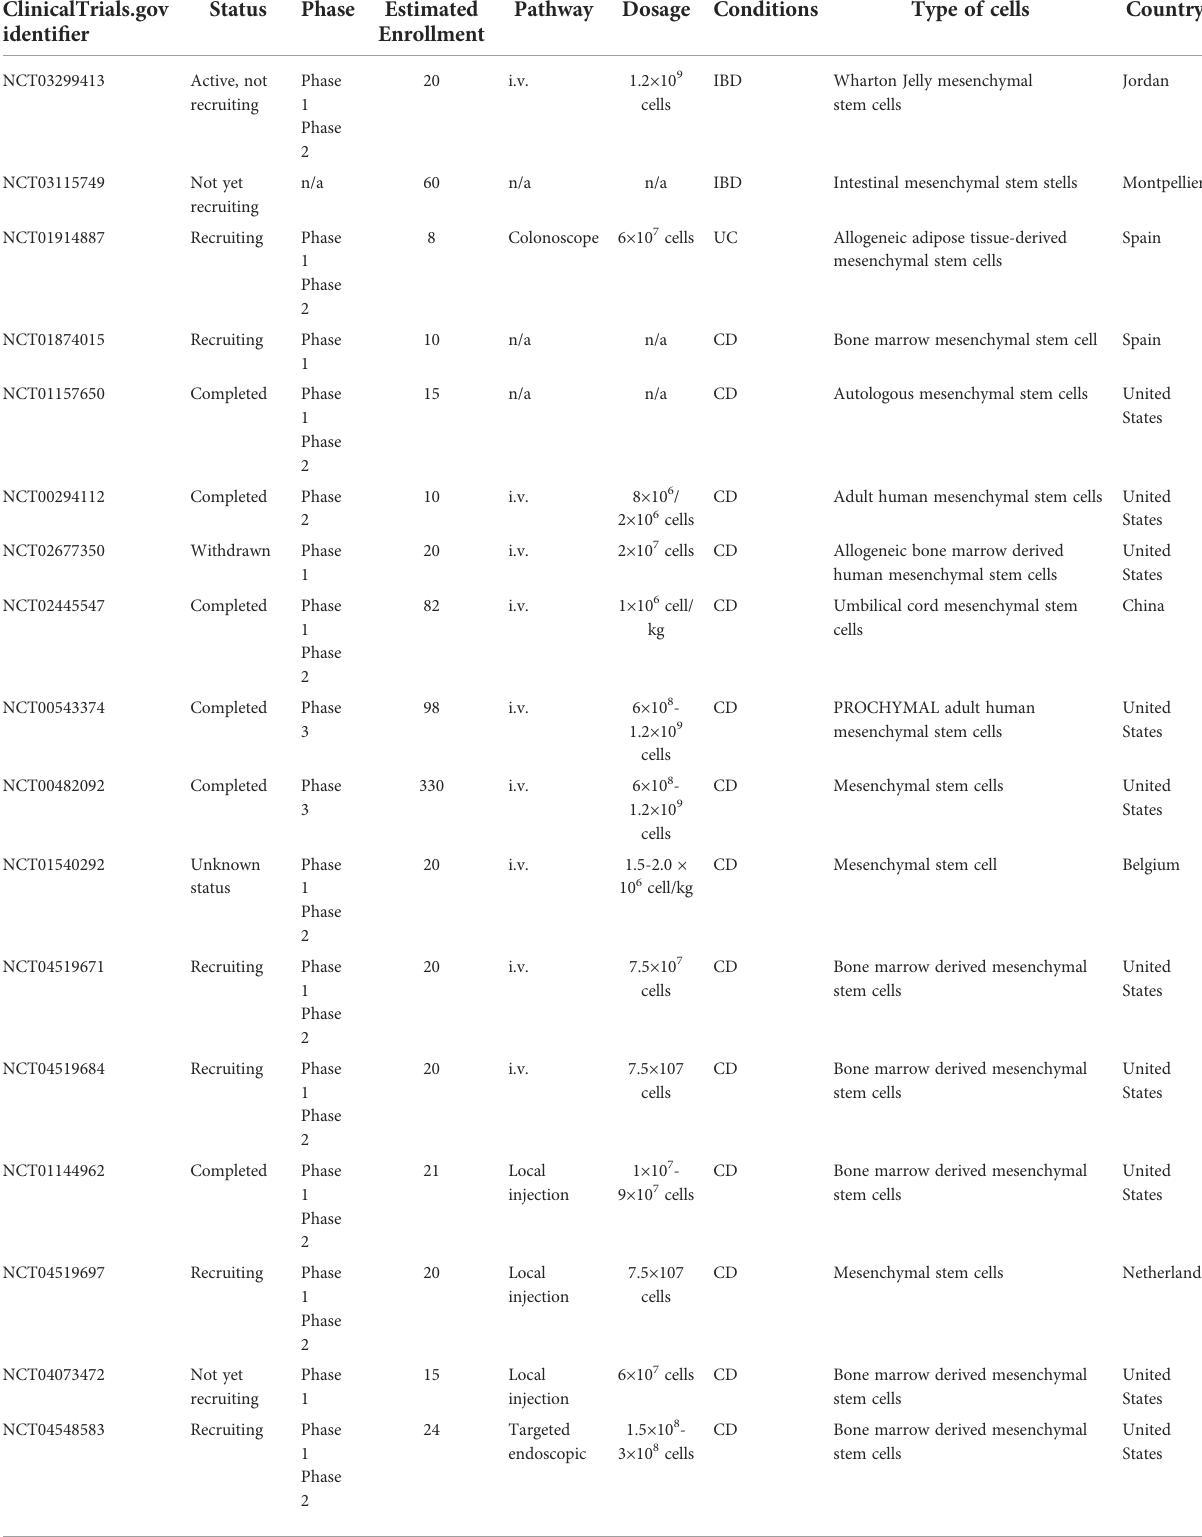
TABLE 3 MSC-based clinical trials for in fl ammatory bowel disease. ClinicalTrials.gov identi fi